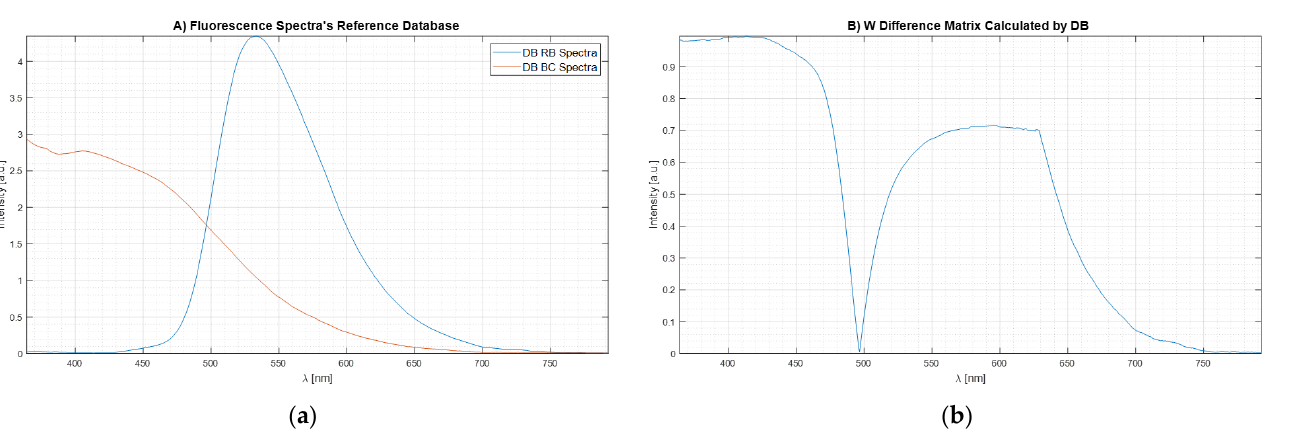
Figure 7. Database spectra of the two agents ( a ); weight matrix for W DIF -LSM ( b ).